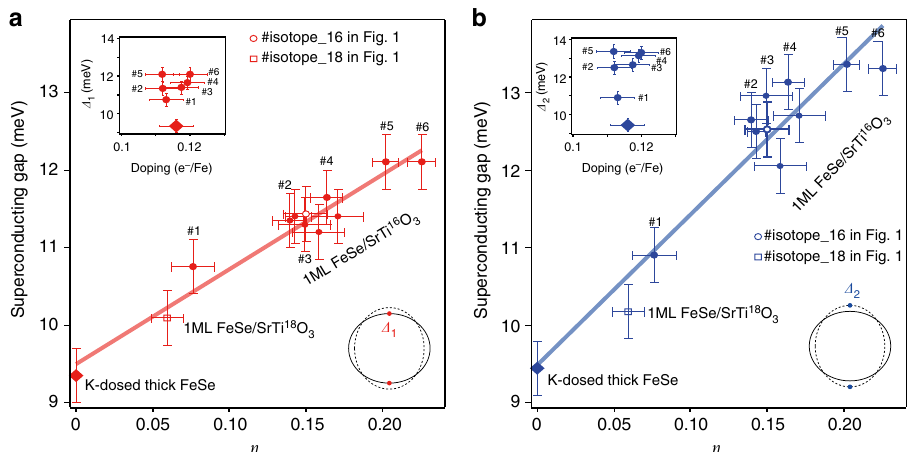
Fig. 4 Superconducting gap as a function of electron – phonon coupling strength. a Superconducting gap sizes Δ 1 and b Δ 2 are plotted as a function of the intensity ratio between the side band γ ′ and the main band γ , i.e., η = Ι 1 / Ι 0 , which is proportional to the interfacial EPI constant 6,24,25 . The red and blue bars are linear fi ts to Δ 1 and Δ 2 , respectively. The insets show the superconducting gap sizes as a function of doping for representative samples. Doping variation is minimal, while the variation in gap sizes does not correlate with the doping. Note: here we use η = Ι 1 / Ι 0 to represent the electron – phonon coupling constant according to theory 6,28 , while using I 1 /( I 1 + I 0 ) would only slightly change the x axis and does not affect the conclusion. The error bar for η is from the standard deviation of the fi ts. The error bar for the superconducting gap is described in Supplementary Figure